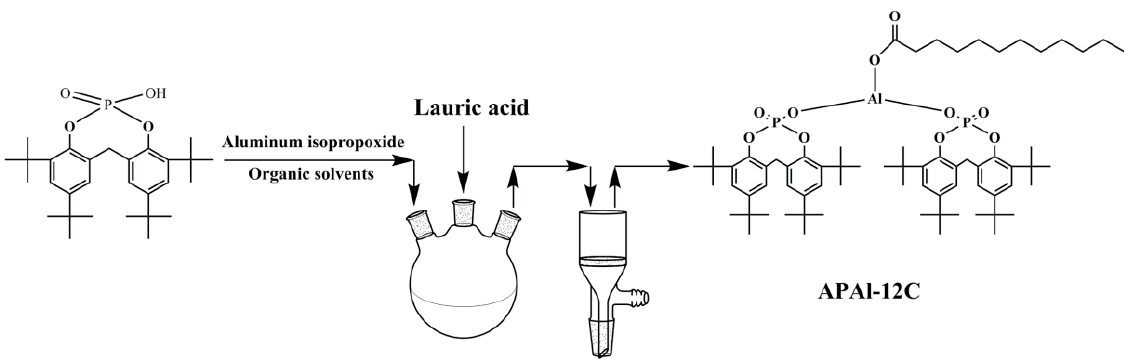
Figure 2. The synthesis of the APAl-12C.